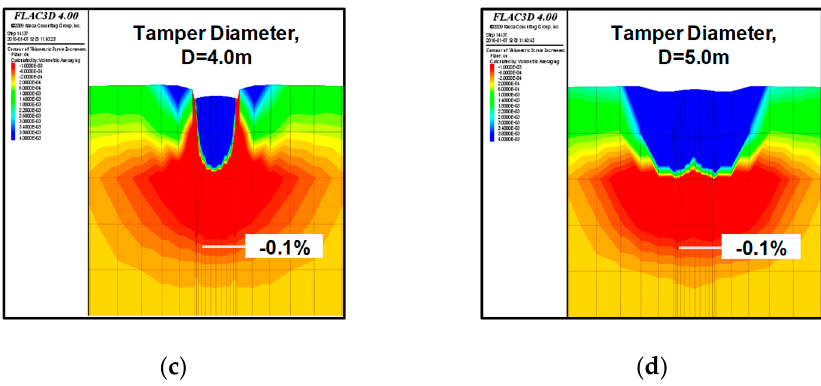
Figure 9. Volumetric strain increment (W = 20 tons, N = 12, H = 15 m): ( a ) ∆ ε v change with depth; ( b ) ∆ ε v contour for D = 3 m; ( c ) ∆ ε v contour for D = 4 m; ( d ) ∆ ε v contour for D = 5 m.